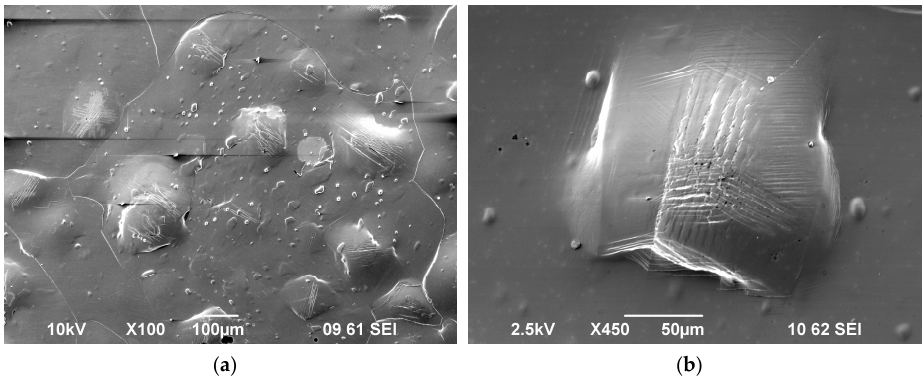
Figure 19. Images of the surface of 99.99996% fine-grained copper after proton beam irradiation taken on a Jeol JCM-5700 electron microscope: ( a ) 100×; ( b ) 450× .